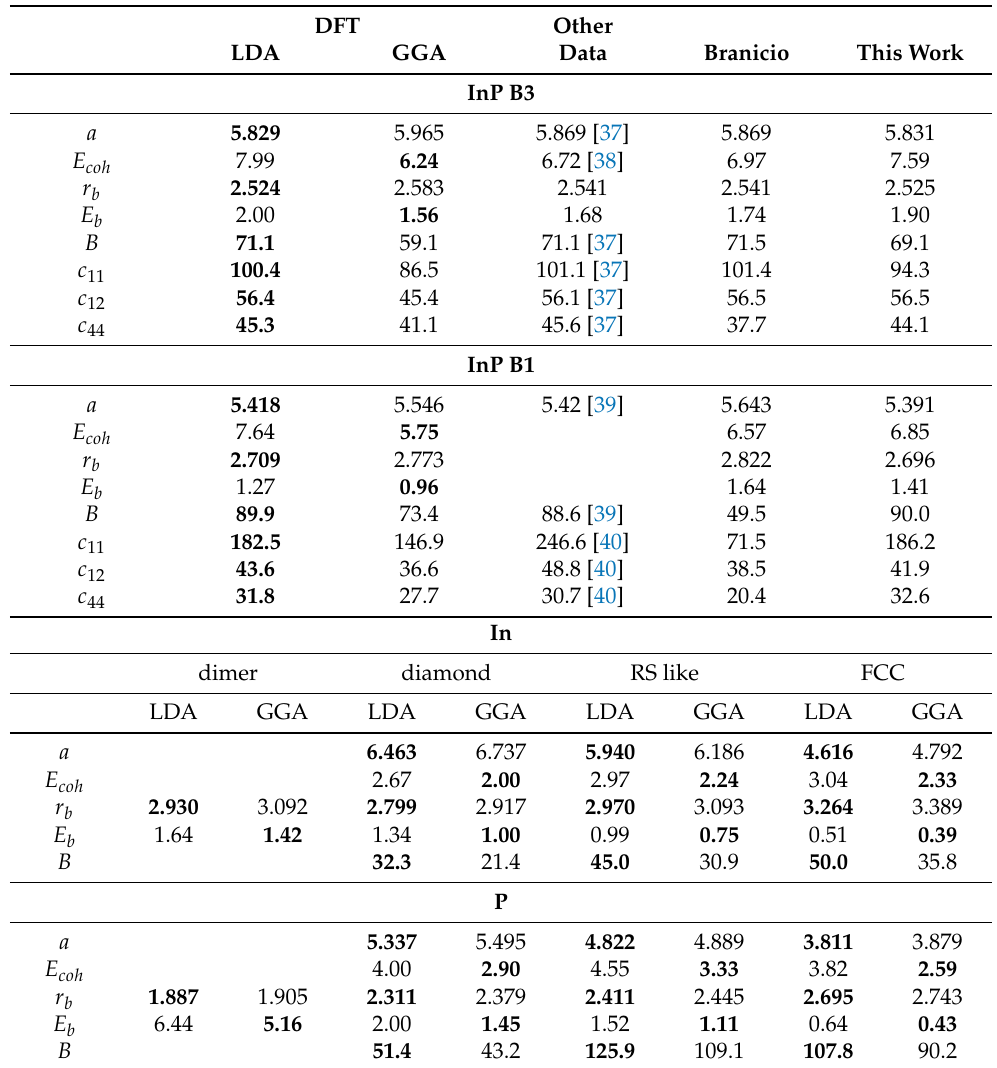
Table 1. The structural, elastic, and cohesive properties of various crystalline phases of InP, In and P: the lattice constant a (Å), the bond length r b (Å), the cohesive energy per formula unit E coh (eV), the cohesive energy per bond E b (eV), the bulk modulus B (GPa), and stiffness coefficients c ij (GPa). The reference data used for fitting are highlighted. DFT